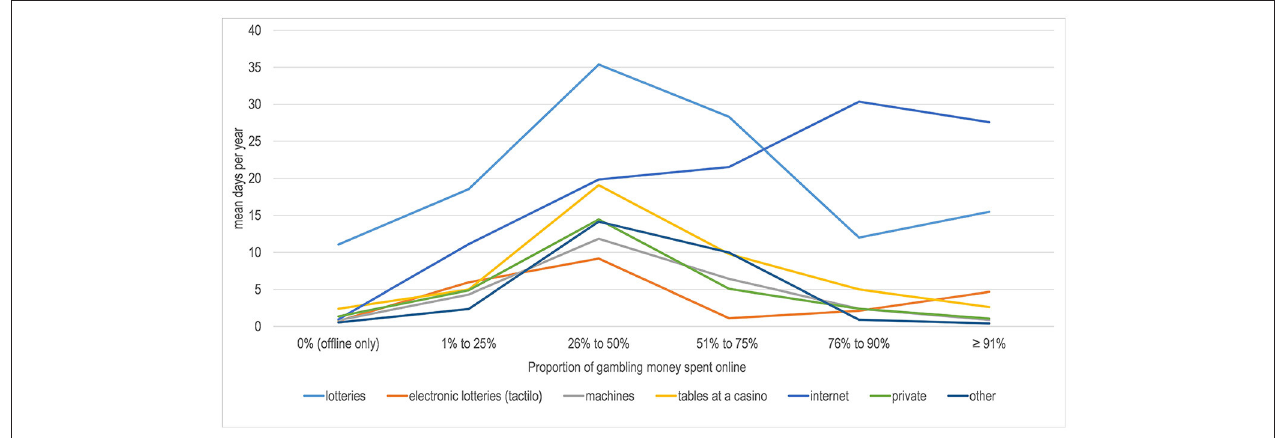
TABLE 5 | Specific gambling-related problems (proportion at least once in the last 12 months) by proportion of money gambled online, and chi-square tests for overall differences across proportion of money spent online (among gamblers, n = 1,526).